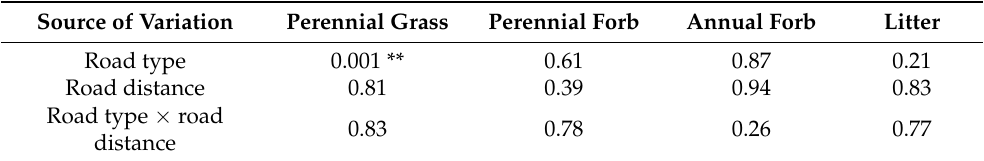
Figure 8. Plant biomass by functional groups at the three distances from the roads. ( a ) The paved road. ( b ) The soil roads. Each bar represents mean ± 1 SE. Table 6. Results of the two-way ANOVA of biomass (road type, distance, and their